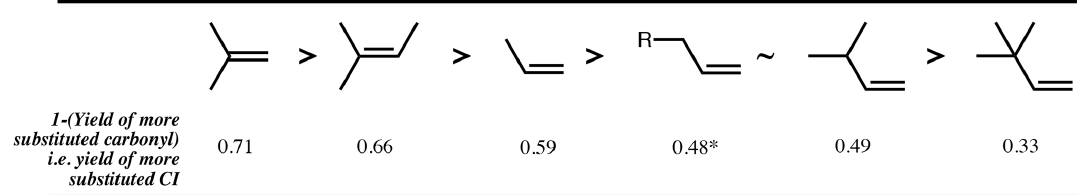
Figure 3. Decreasing order of preference, from left to right, of more substituted CI formation from ozonolysis of example alkyl-substituted alkenes. Values are 1 (mean of measured yields of carbonyls) (Spreadsheet S1). ∗ : mean measured yield of propanal (i.e. 1 – more substituted CI) formation from 1-butene is 0.35, but for all other 1-alkenes the yield of the larger primary carbonyl product ranges from 0.45 to